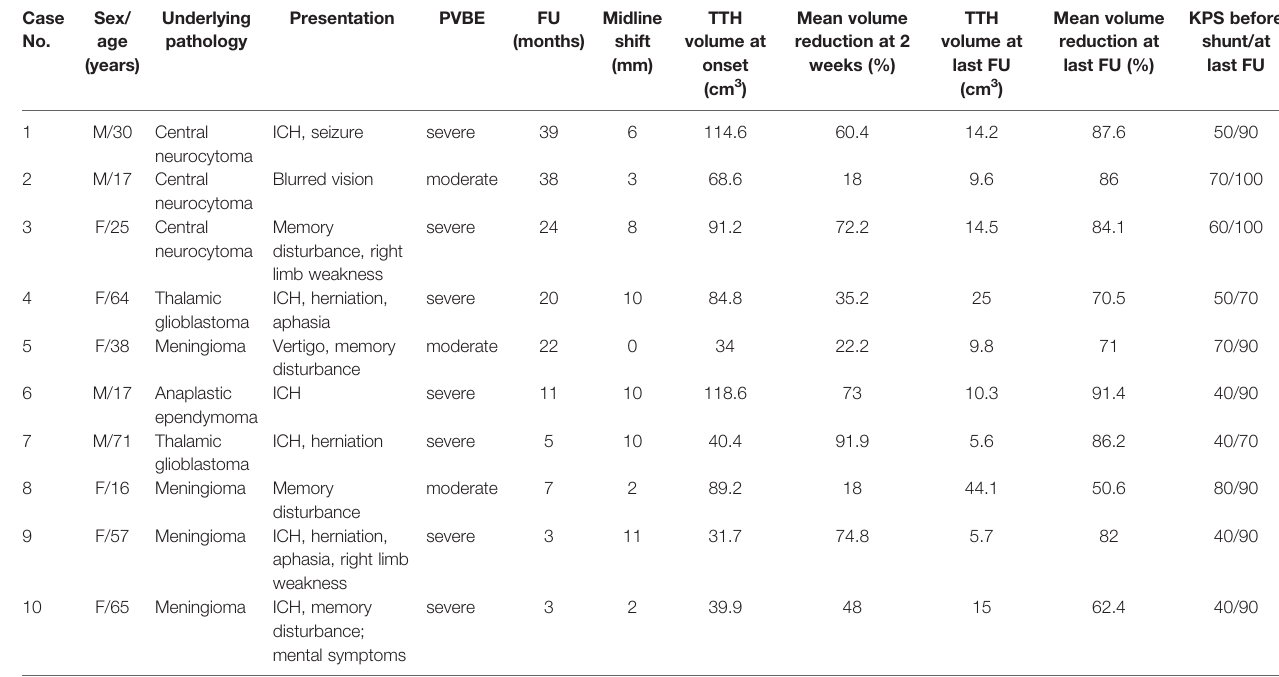
TABLE 1 | Baseline characteristics of patients with trapped temporal horn who were treated with re fi ned temporal-to-frontal horn shunt a . Case